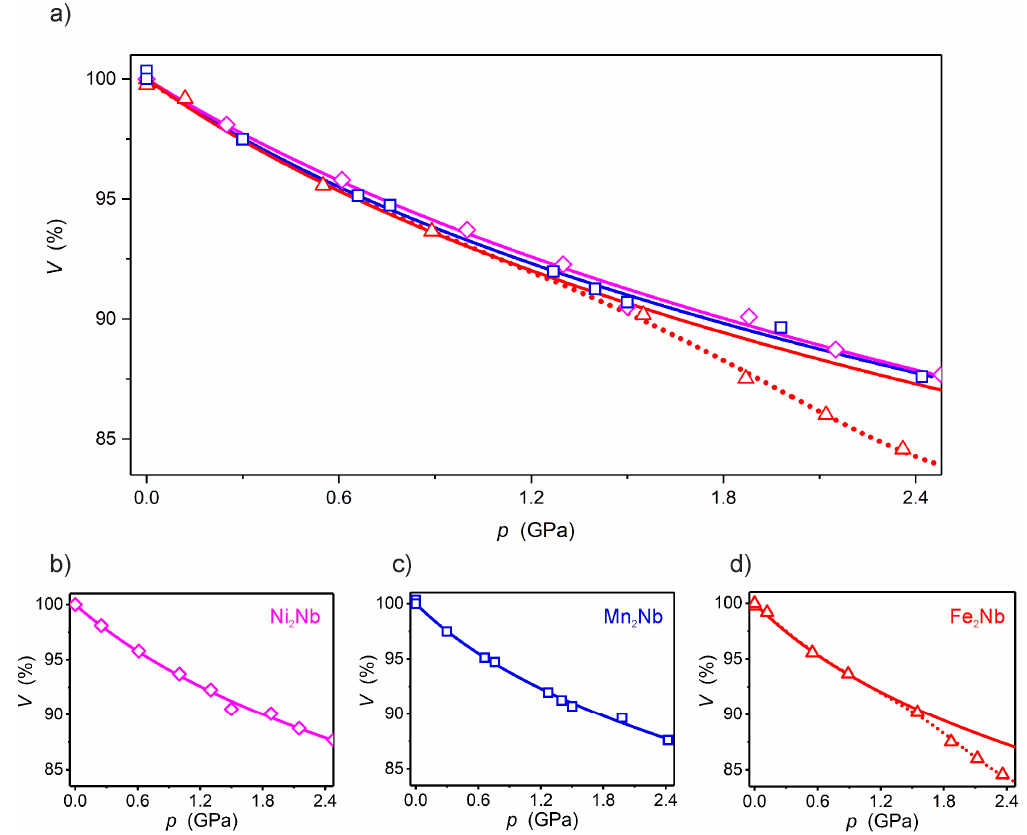
Figure 2. Combined graph ( a ) of V / V 0 ( p ) dependencies for Ni 2 Nb (magenta) ( b ), Mn 2 Nb (blue) ( c ) and Fe 2 Nb (red) ( d ). The solid lines are the best fit to the Birch–Murnaghan equation of state (BMEOS). The dotted line for Fe 2 Nb above 1.2 GPa is only a guide for the eye.